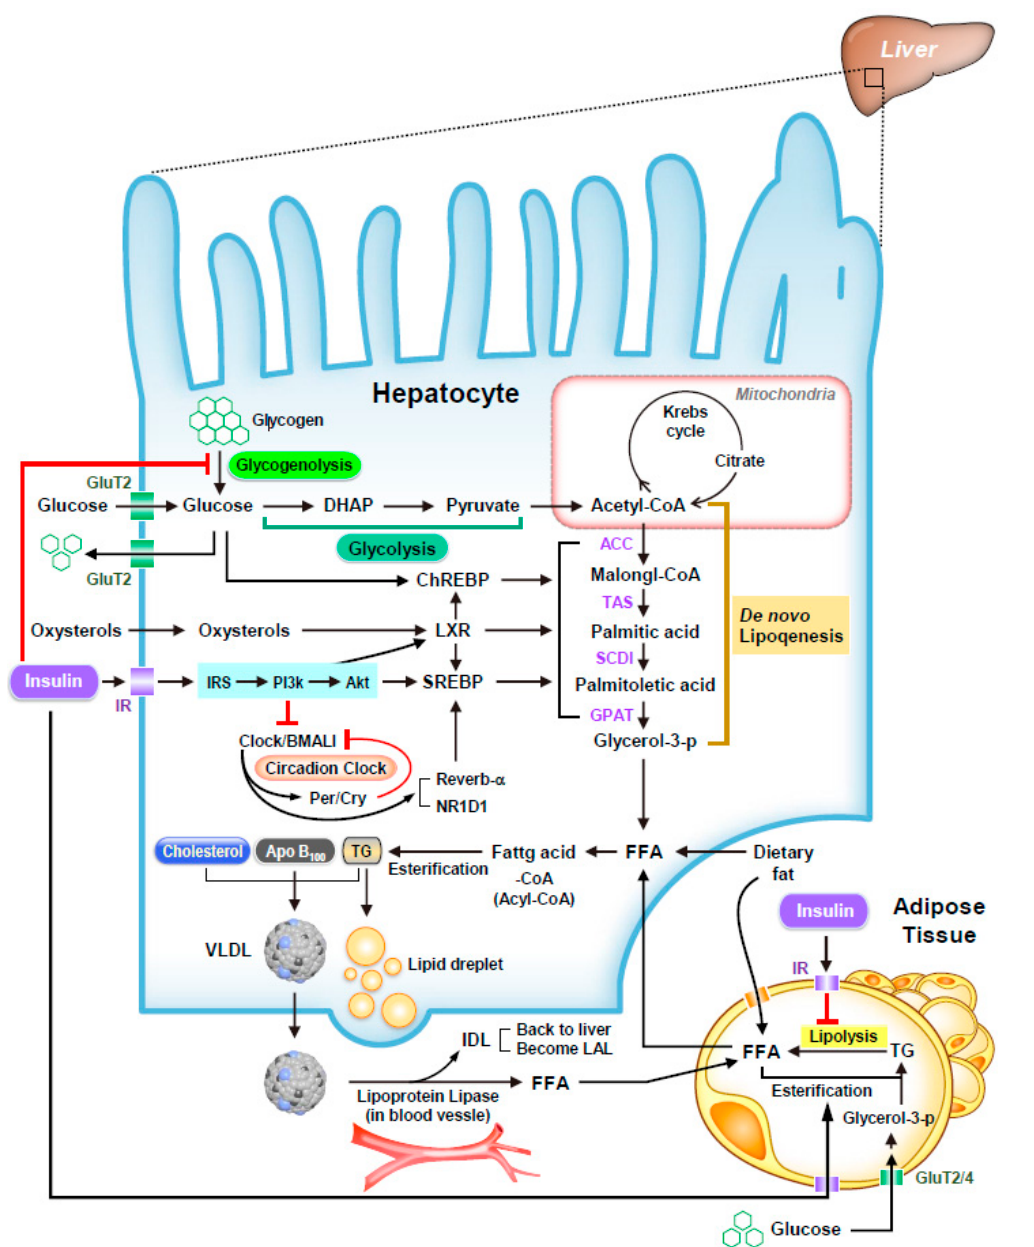
Figure 1. The hepatic metabolism of lipid and carbohydrate through insulin induced transcriptional regulation and circadian clock. Insulin signals and insulin-induced regulators: The schematic depicts the synergistic action of insulin and glucose in regulating lipogenesis in the liver and adipose tissue. Most of the insulin-mediated metabolic actions are controlled by the PI3K-AKT/PKB pathway. Under insulin stimulation, glycogenolysis is inhibited by activating PP1 and phosphodiesterase. Insulin activates the transcription of Srebp-1c and the proteolytic processing of SREBP-1c protein. The insulin-induced Srebp-1c transcription is facilitated by LXR and SREBPs themselves. LXR promotes lipogenesis not only primarily by increasing Srebp-1c expression, but also directly activate the promoters of Chrebp and some lipogenic genes. ChREBP is also activated by glucose signal by multiple mechanisms for the further progression of lipogenesis. Metabolism of glucose and lipid: After diet, vascular endothelium in adipose tissue absorbs and hydrolyzes triglycerides into non-esterified fatty acids by insulin-activated lipoprotein lipase. As released fatty acids are conveyed into adipocyte by fatty acids transporters, fatty acids are then re-esterified using glycerol 3-phosphate derived from glucose as a backbone to form triglycerides and stored as lipid droplets. Whereas fasting will promote lipolysis to convert triglycerides within lipid droplets into free fatty